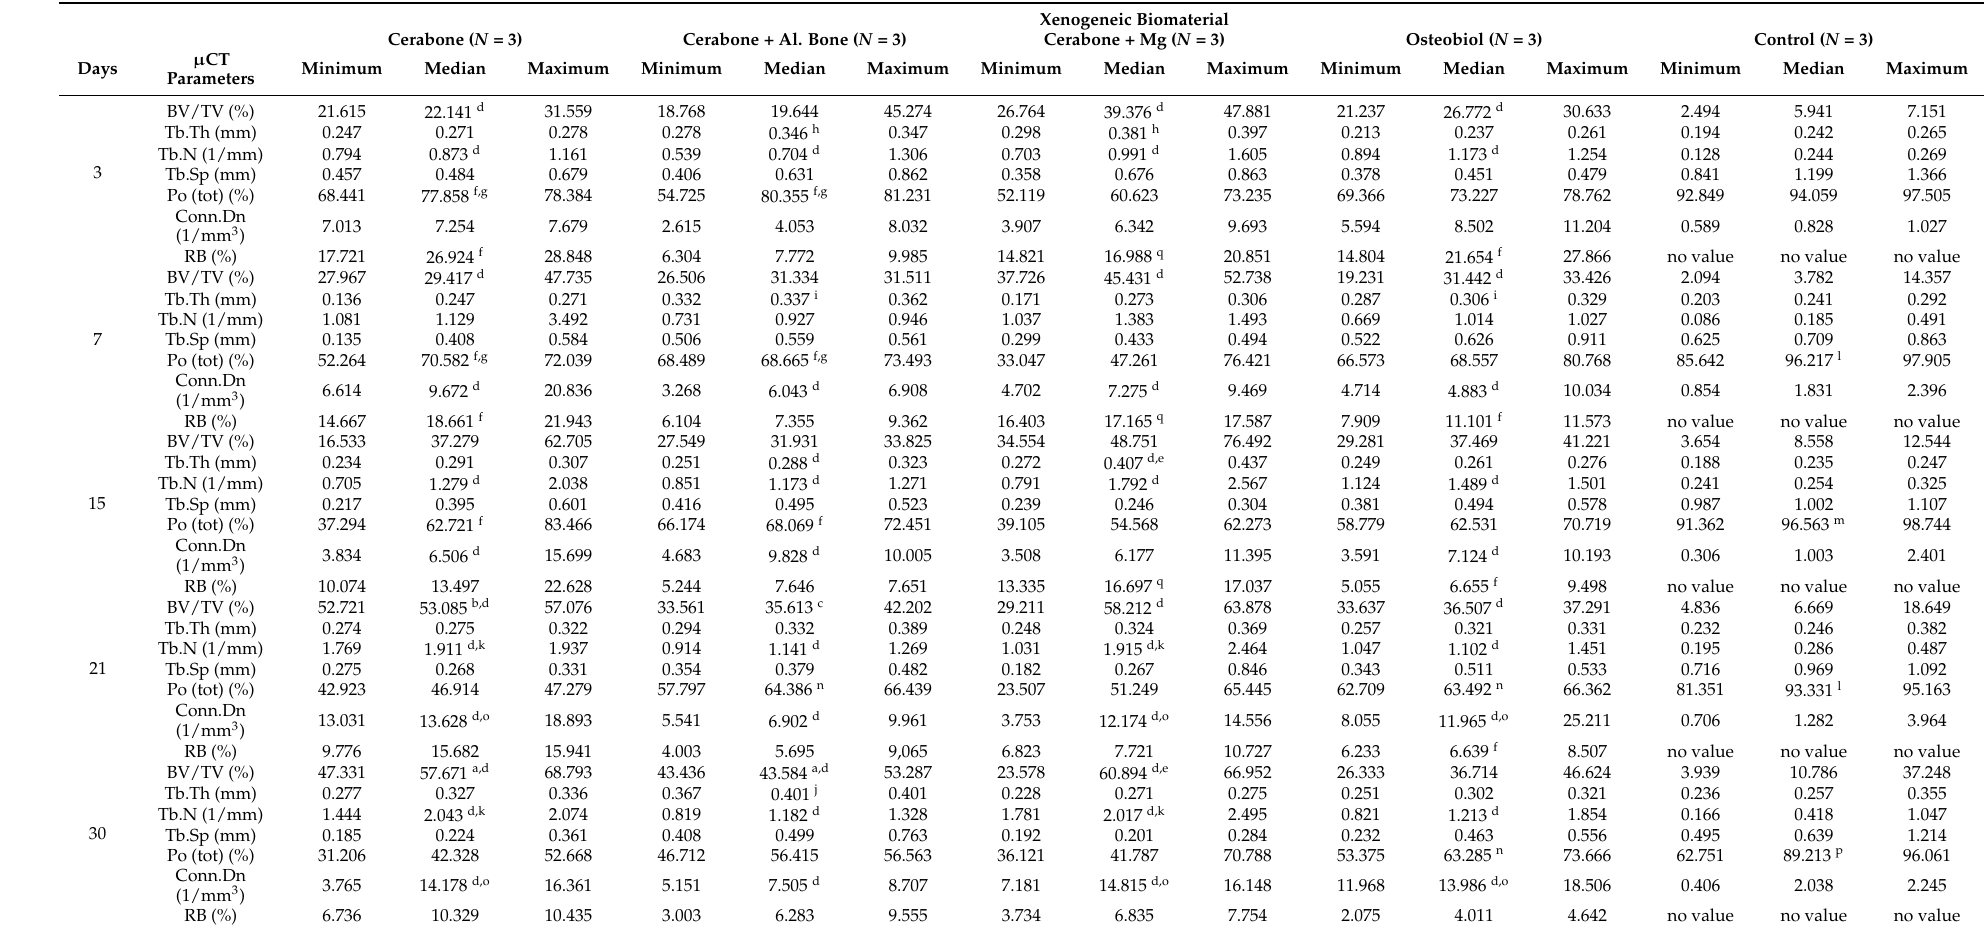
Table 1. Micro-CT bone morphometric parameters comparison between xenogeneic